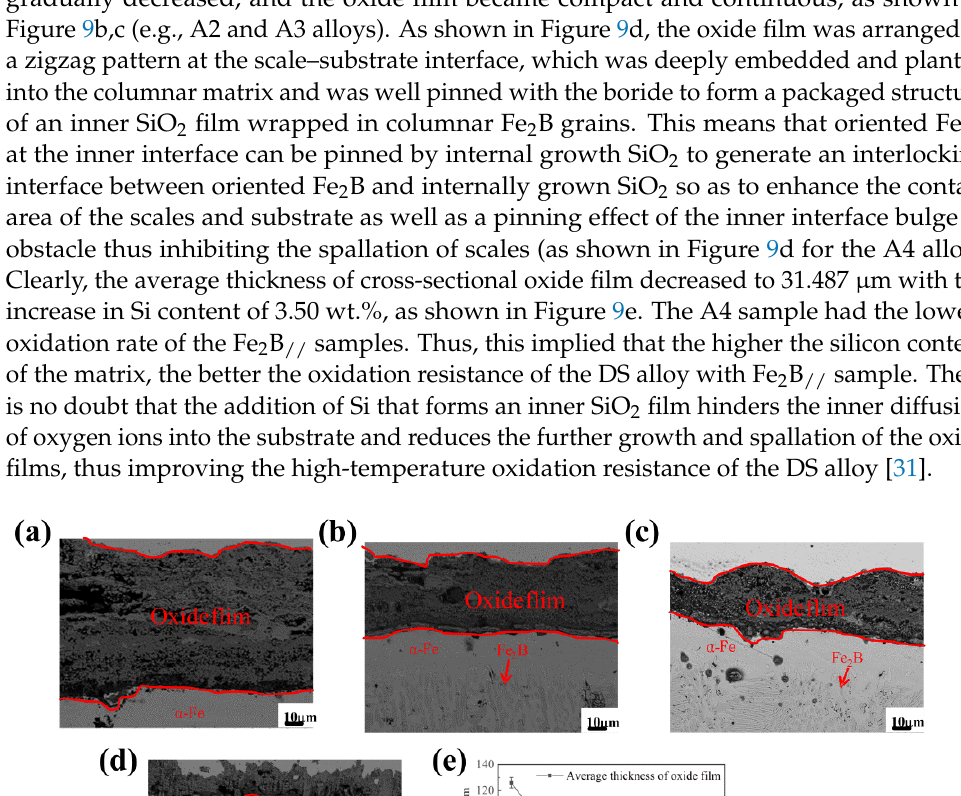
Figure 10. The BSE micrographs of the cross-section of Fe 2 B ⊥ samples oxidized for 60 h at 1073 K: ( a ) alloy A1, ( b ) alloy A2, ( c ) alloy A3, ( d ) alloy A4, ( e ) the thickness of cross-sectional oxide film.